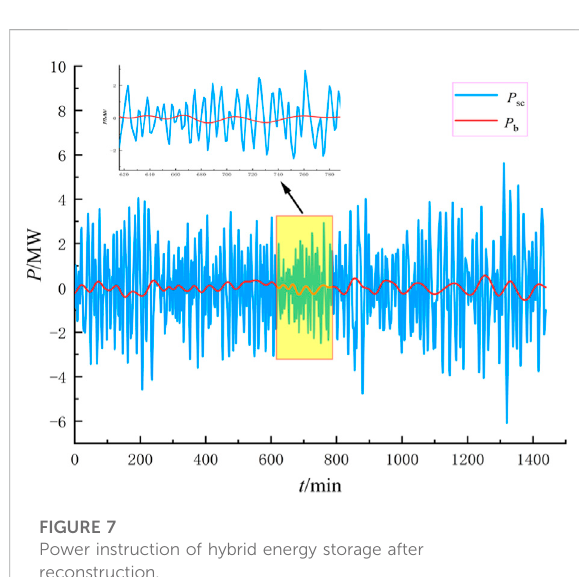
Power instruction of hybrid energy storage after